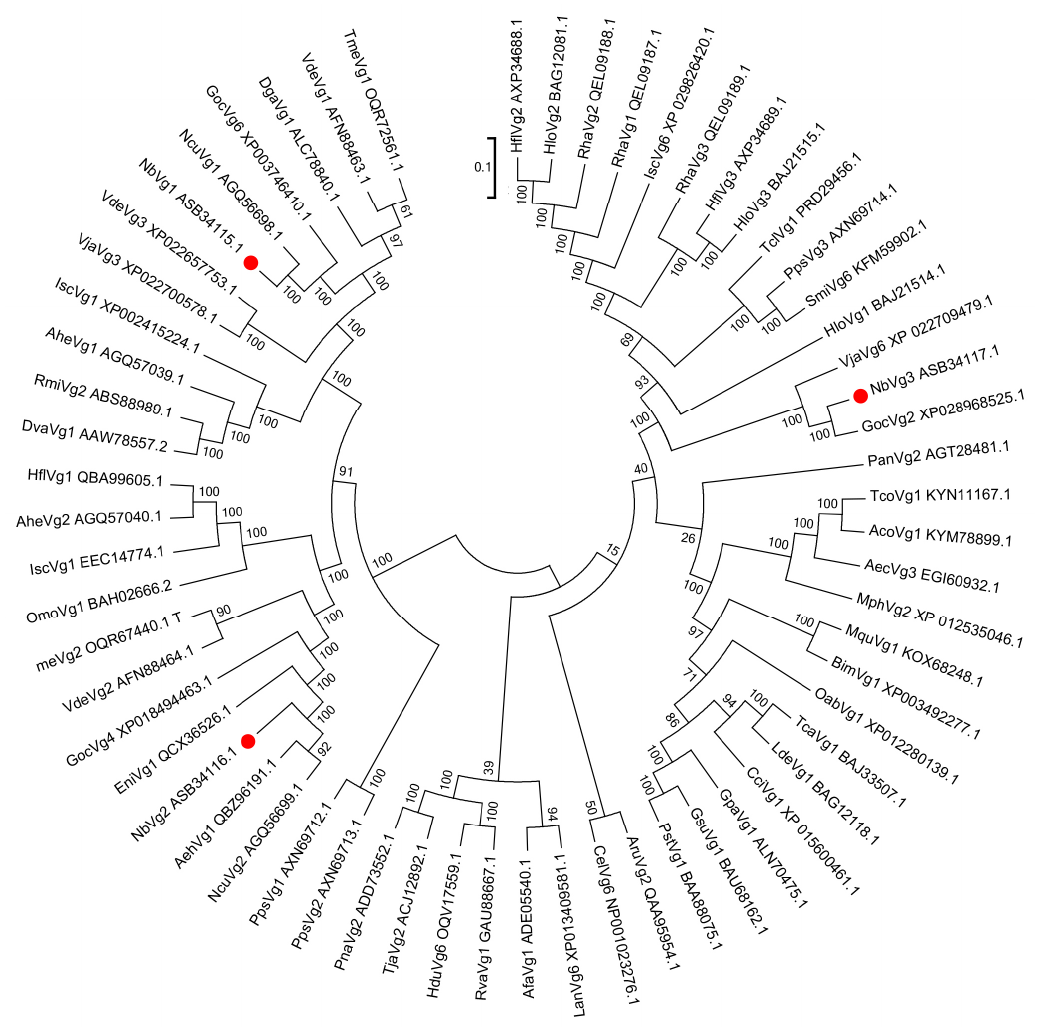
Figure 6. Phylogenetic tree of N. barkeri Vgs constructed using the neighbor-joining method in MEGA software (version: 7.0). Each branch shows bootstrap values from 1000 replications. Tables S1–S3 list the Vgs sequences used in this analysis.